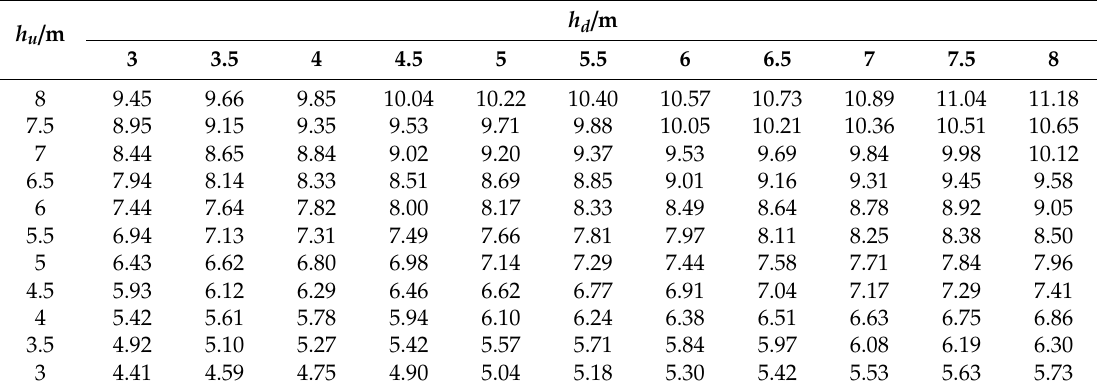
Table 2. Maximum vacuum, H pm , at di ff erent h u and h d